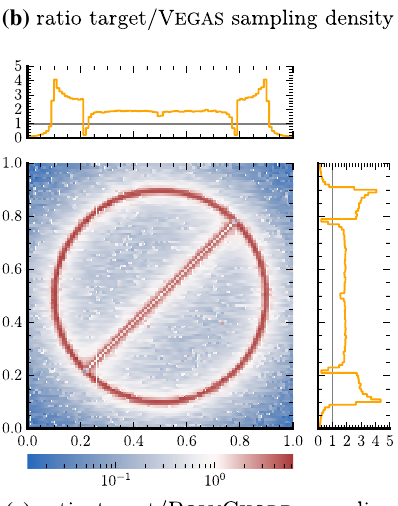
Fig. 2 A two-dimensional toy example: a Histogram of the target function along with the marginal sampling distributions of V EGAS and PolyChord . b Ratio of the target function and the probability density function of V EGAS . c Ratio of the target density to the sampling density of